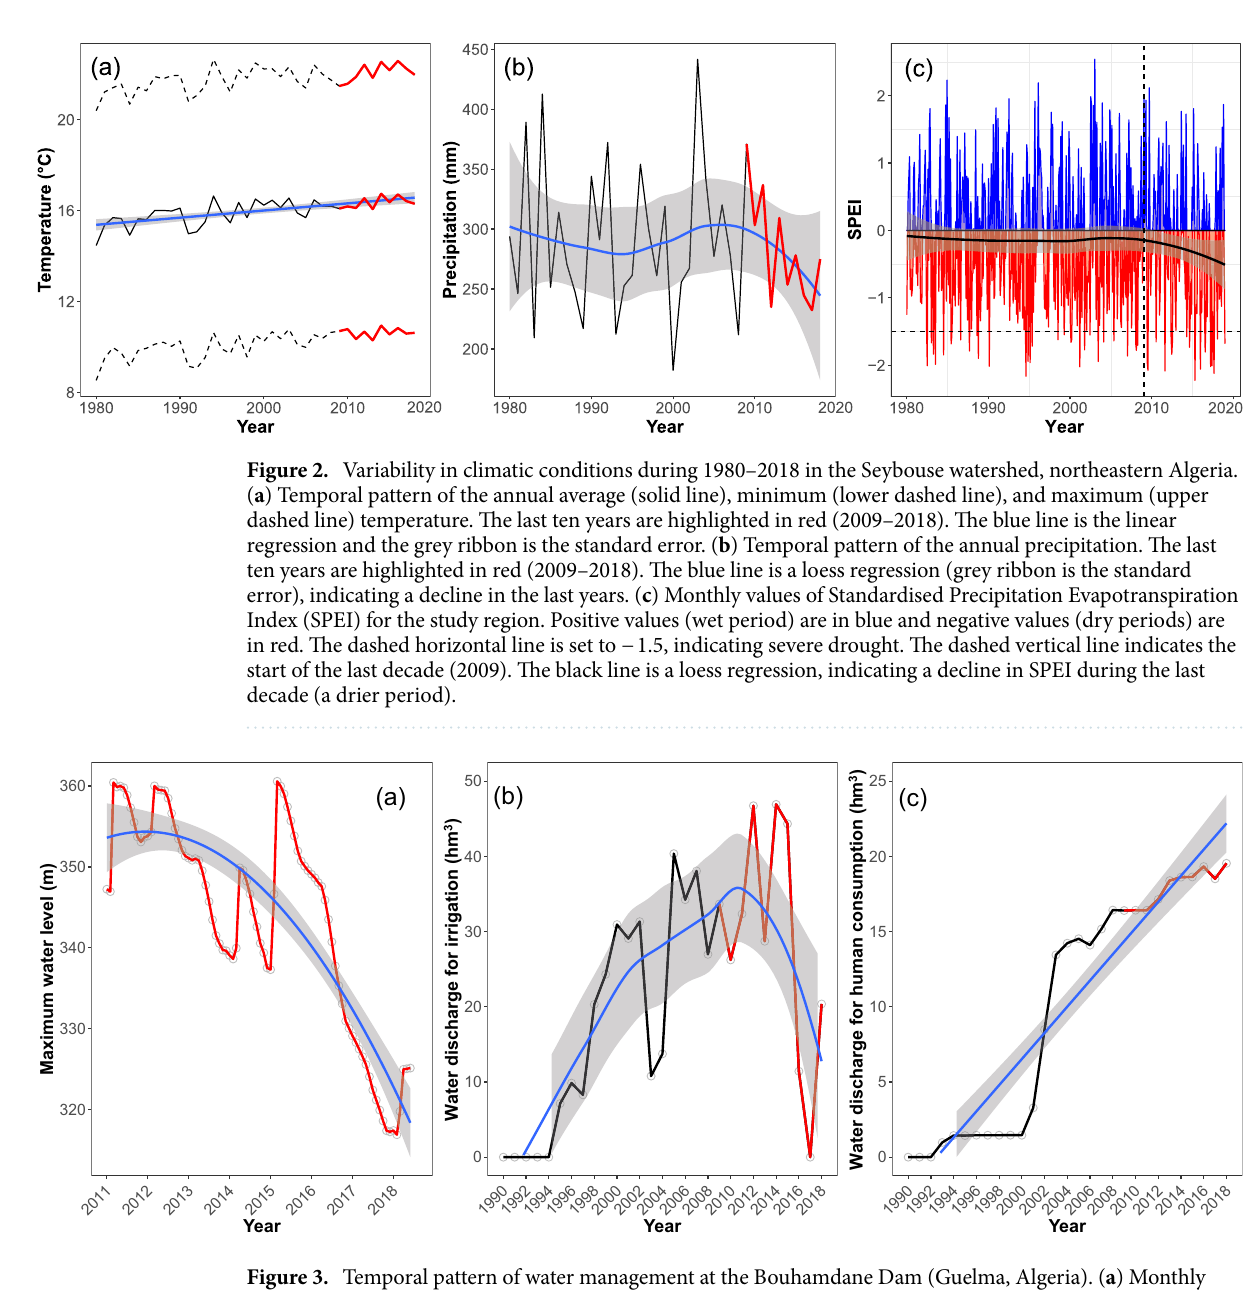
Figure 3. Temporal pattern of water management at the Bouhamdane Dam (Guelma, Algeria). ( a ) Monthly values of the maximum water level during 2011–2018. The blue line is a quadratic regression and the grey ribbon is the standard error. ( b ) Estimated discharge quantity for irrigation during 1990–2018. The blue line is a loess regression and the grey ribbon is the standard error. The last ten years are highlighted in red (2009–2018). ( c ) Estimated discharge quantity for human consumption during 1990–2018. The blue line is a linear regression and grey ribbon is the standard error. The last ten years are highlighted in red